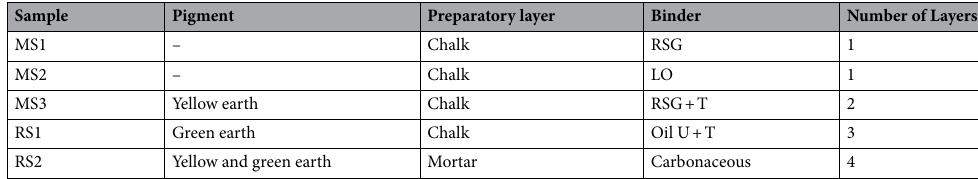
Table 1. Different samples regarding their porosity and conductivity were used for the experiment. MS1 and MS2 are not conductive, while MS3, RS1 and RS2 have some metallic particles (iron) in their pigmented layers. MS: Model sample; RS: Real sample; RSG: Rabbit skin glue; LO: Linseed oil; T: Tempera; U: